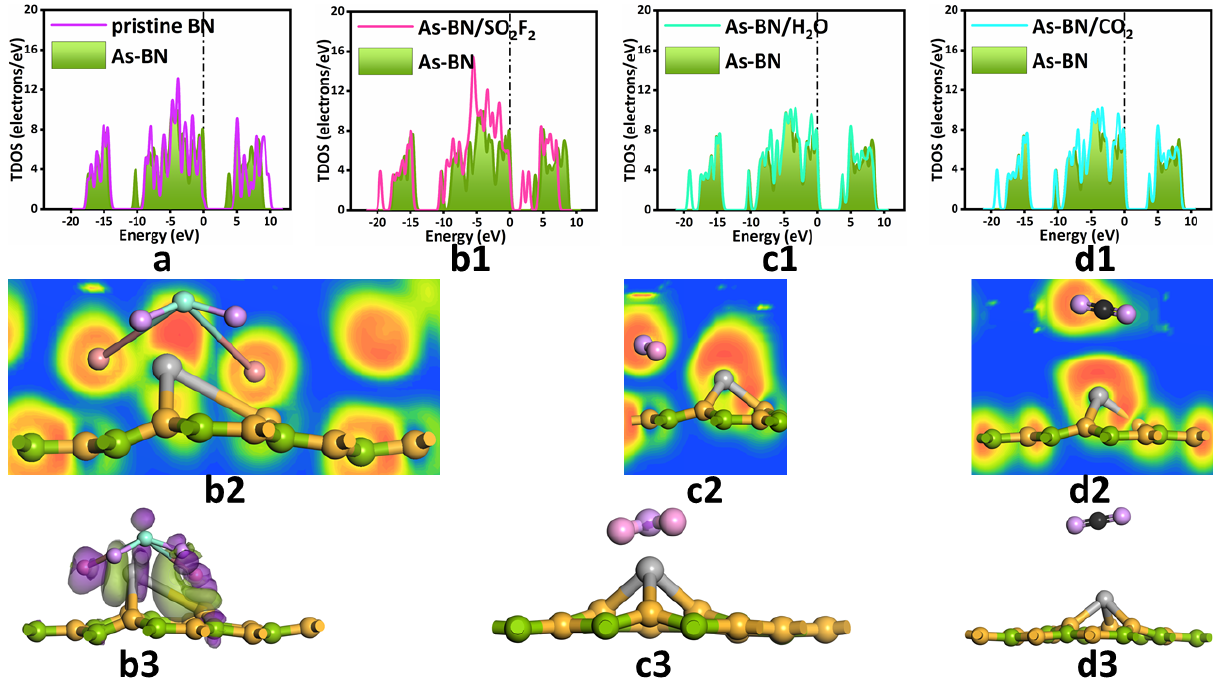
Figure 2. ( a ) The TDOS of h − BN monolayer and As − BN monolayer. The TDOS, ELF, and CDD